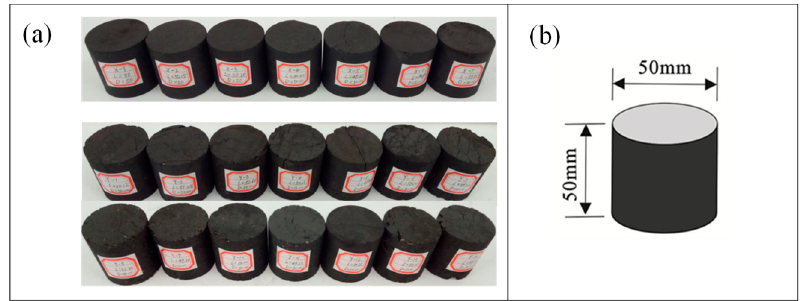
Figure 1. Preparation of experimental coal specimens: ( a ) photograph of prepared specimens, ( b ) geometry size of the specimen.